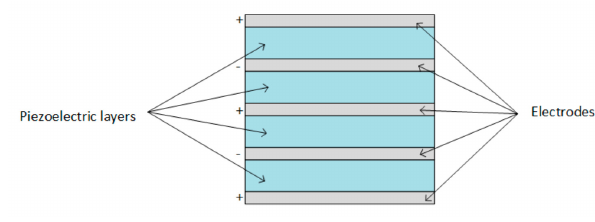
Figure 6. Stack Piezoelectric Transducers. 1